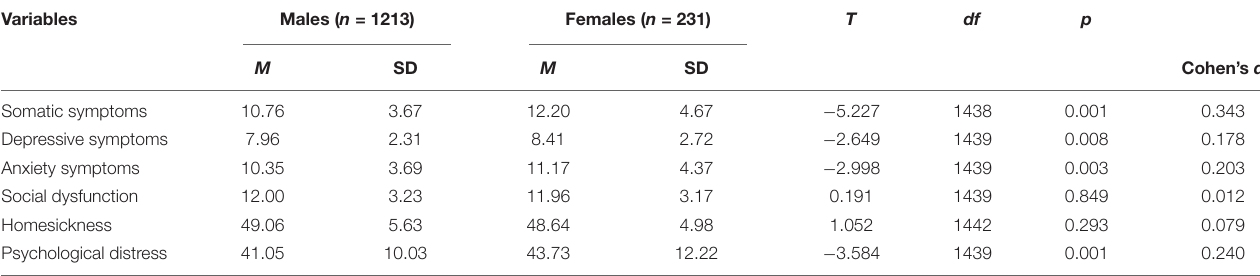
TABLE 2 | Gender differences in distress, somatic symptoms, depressive symptoms, anxiety symptoms, social dysfunction, and homesickness. Variables